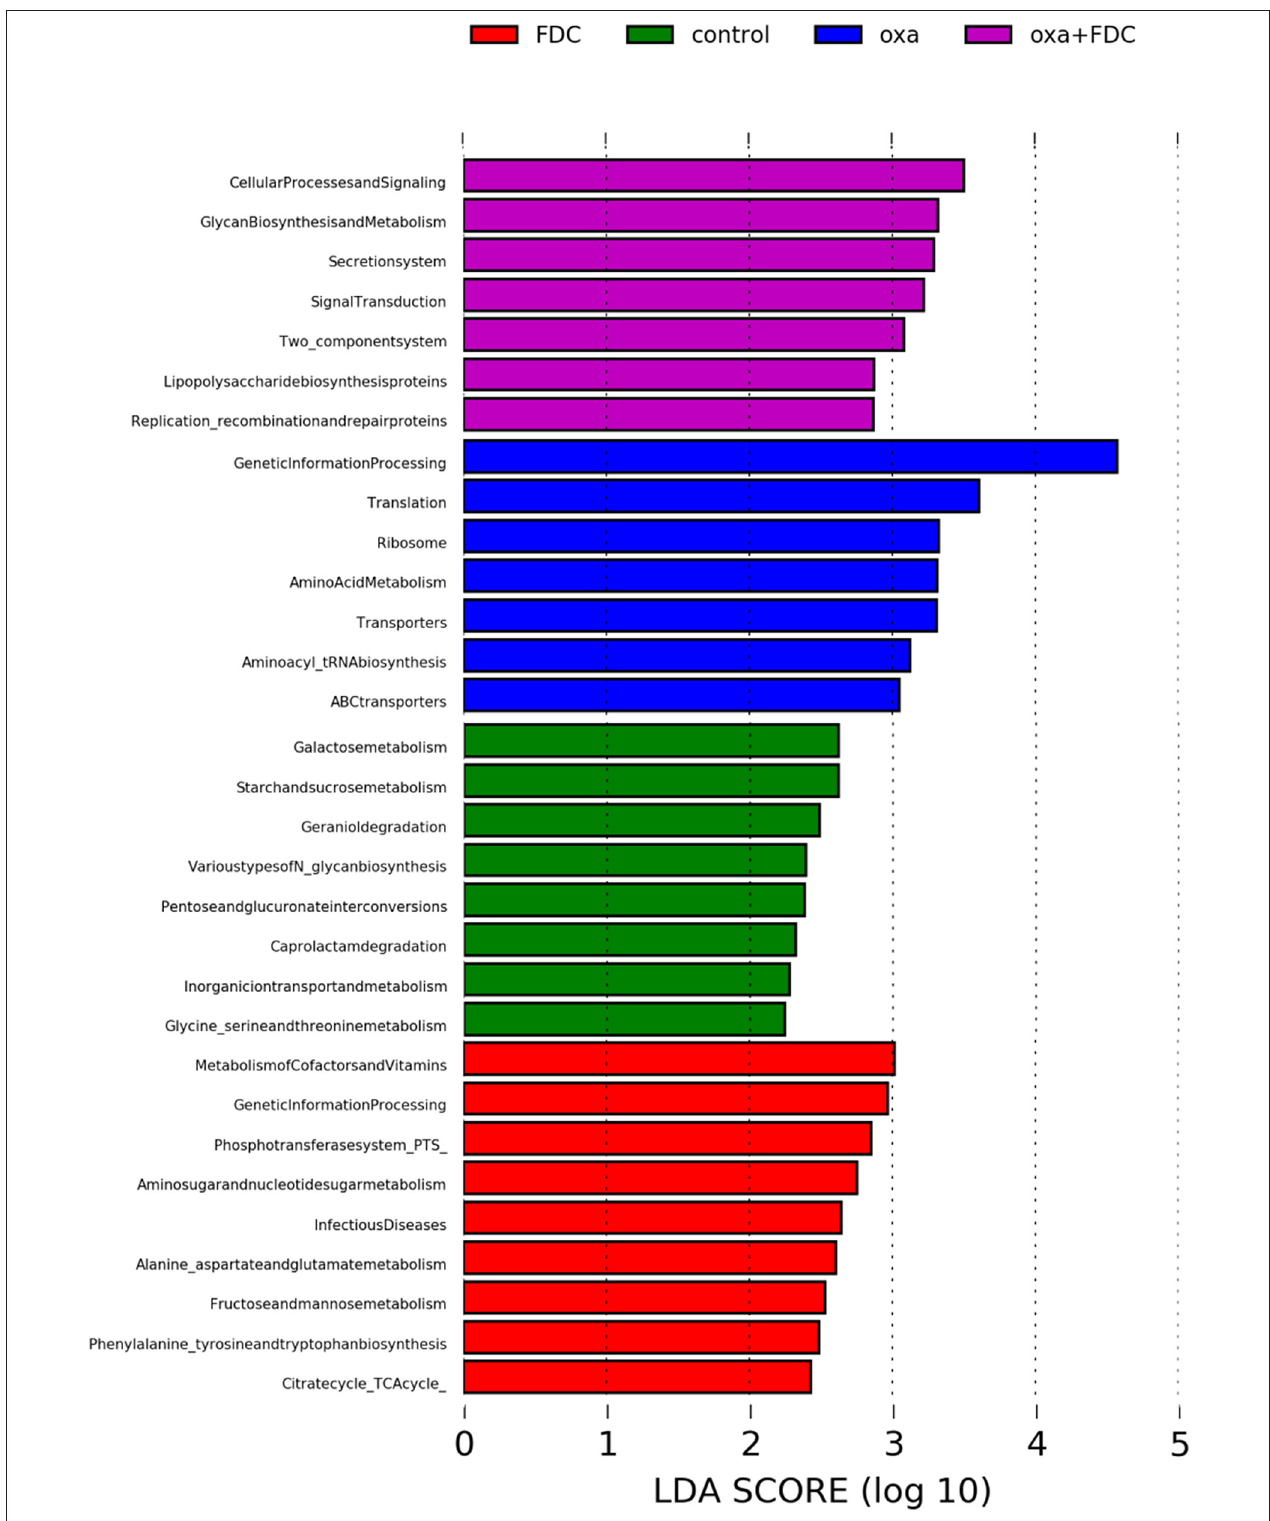
FIGURE 6 | Analysis of differences in KEGG metabolic pathways on day